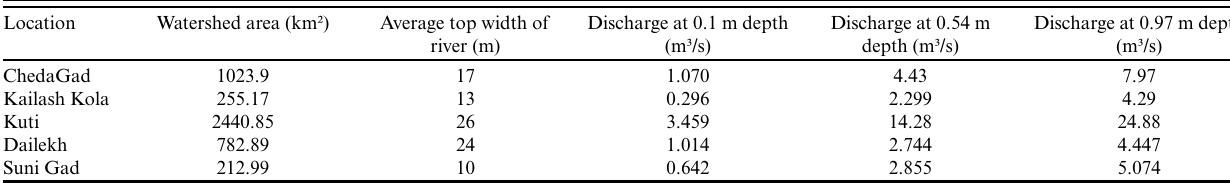
Table 3. River discharge corresponding to identified minimum water depth at some locations. (The names of locations are indicative only and represent areas where river cross section and flow velocity data were available).